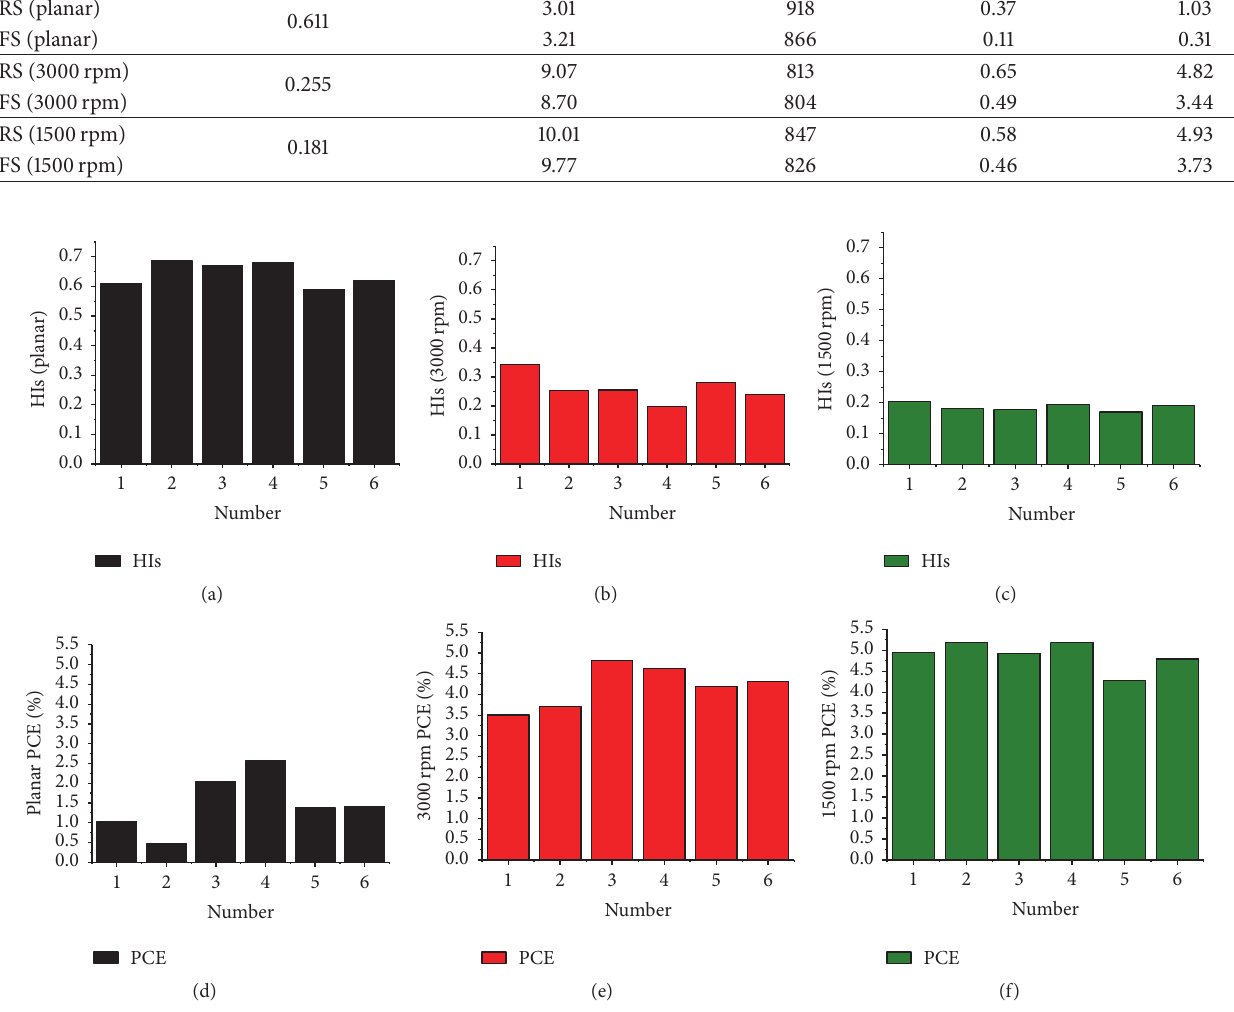
Figure 9: HIs of six perovskite solar cells with (a) planar structure and the spin-coating rate of the mp-TiO 2 precursor for (b) 3000 rpm and (c) 1500 rpm. PCEs of six perovskite solar cells with (d) planar structure and the spin-coating rate of the mp-TiO 2 precursor for (e) 3000 rpm and (f)